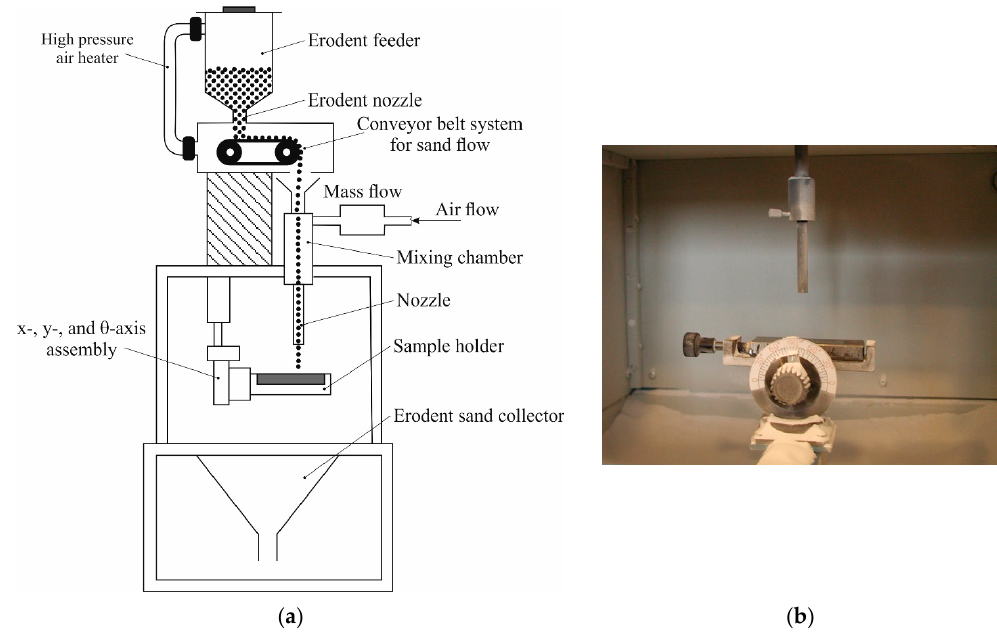
Figure 2. Erosion resistance test rig according to ASTM G 76-2: ( a ) a schematic view, ( b ) the interior view of the erosion measuring chamber.